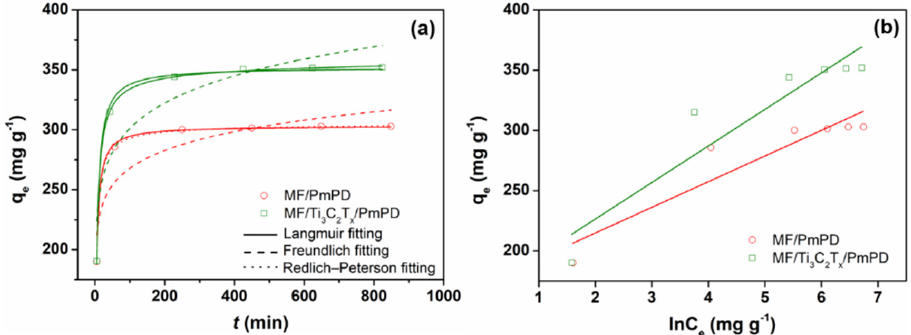
Figure 7. The fitting curves of Langmuir, Freundlich, R–P ( a ) and Temkin ( b ) models. Table 1. The correlation coefficient of Langmuir, Freundlich, R–P and Temkin models fitting. Adsorbents